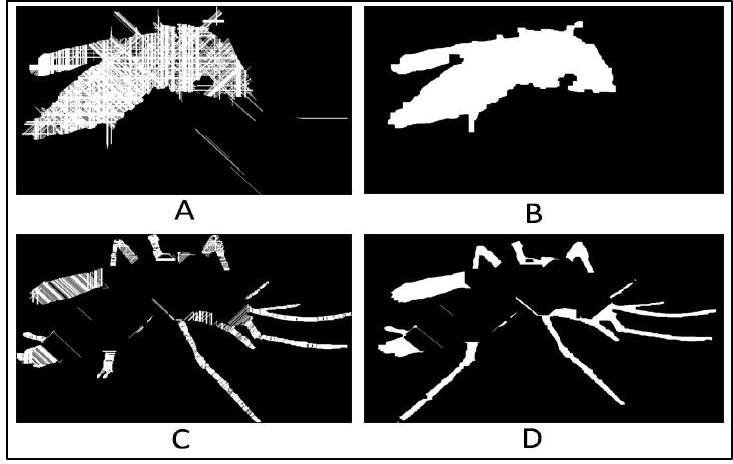
Figure 5. The contour image of the trunk region ( A ); the extracted trunk region ( B ); the contour image of the leg region ( C ); and the extracted leg region ( D ).